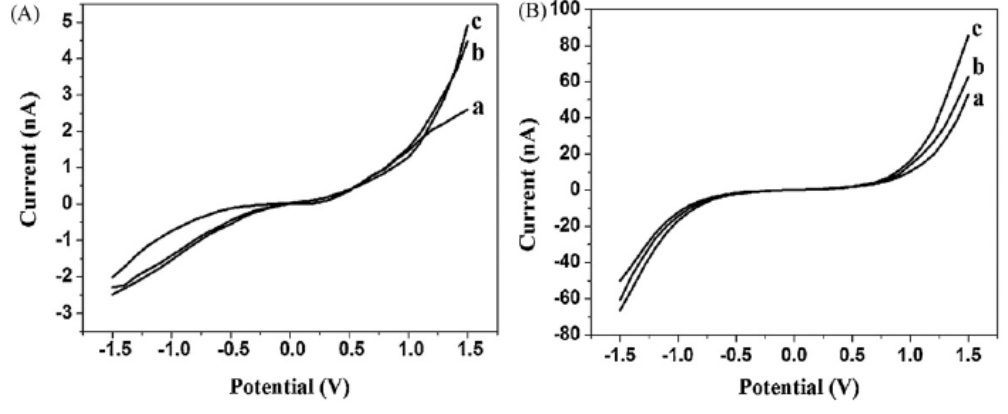
Figure 6. Electrical detection of DNA: (A) I-V curves of s-AuNPs: (a) bare s-AuNPs, (b) s-AuNPs with single-stranded DNA (ss-DNA, probe DNA), and (c) s-AuNPs with double- stranded DNA (ds-DNA); (B) I-V curves of sg-AuNPs: (a) bare sg-AuNPs, (b) sg-AuNPs with ss-DNA, and (c) sg-AuNPs with ds-DNA. Reprinted with permission from [86]. Copyright (2008) Elsevier